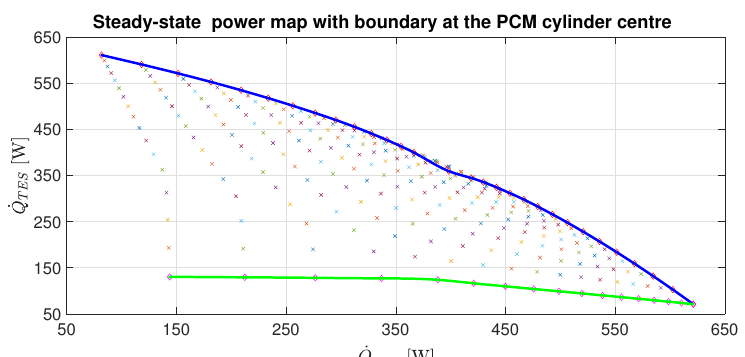
Figure 8. Steady-state cooling power map for mode 1 when the freezing/melting boundary locates at the PCM cylinder